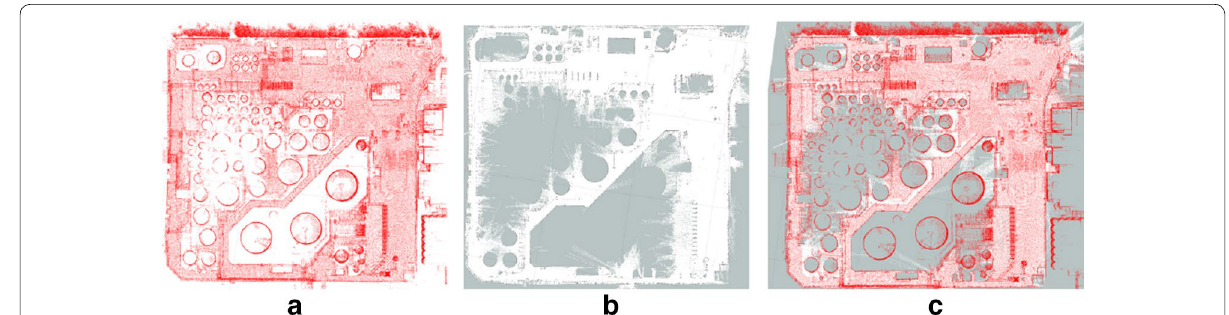
Fig. 18 Data in petrochemical complexes: a red denotes MMS point-cloud data; b 2D map by proposed method; c using GPS position, MMS data overlap our 2D